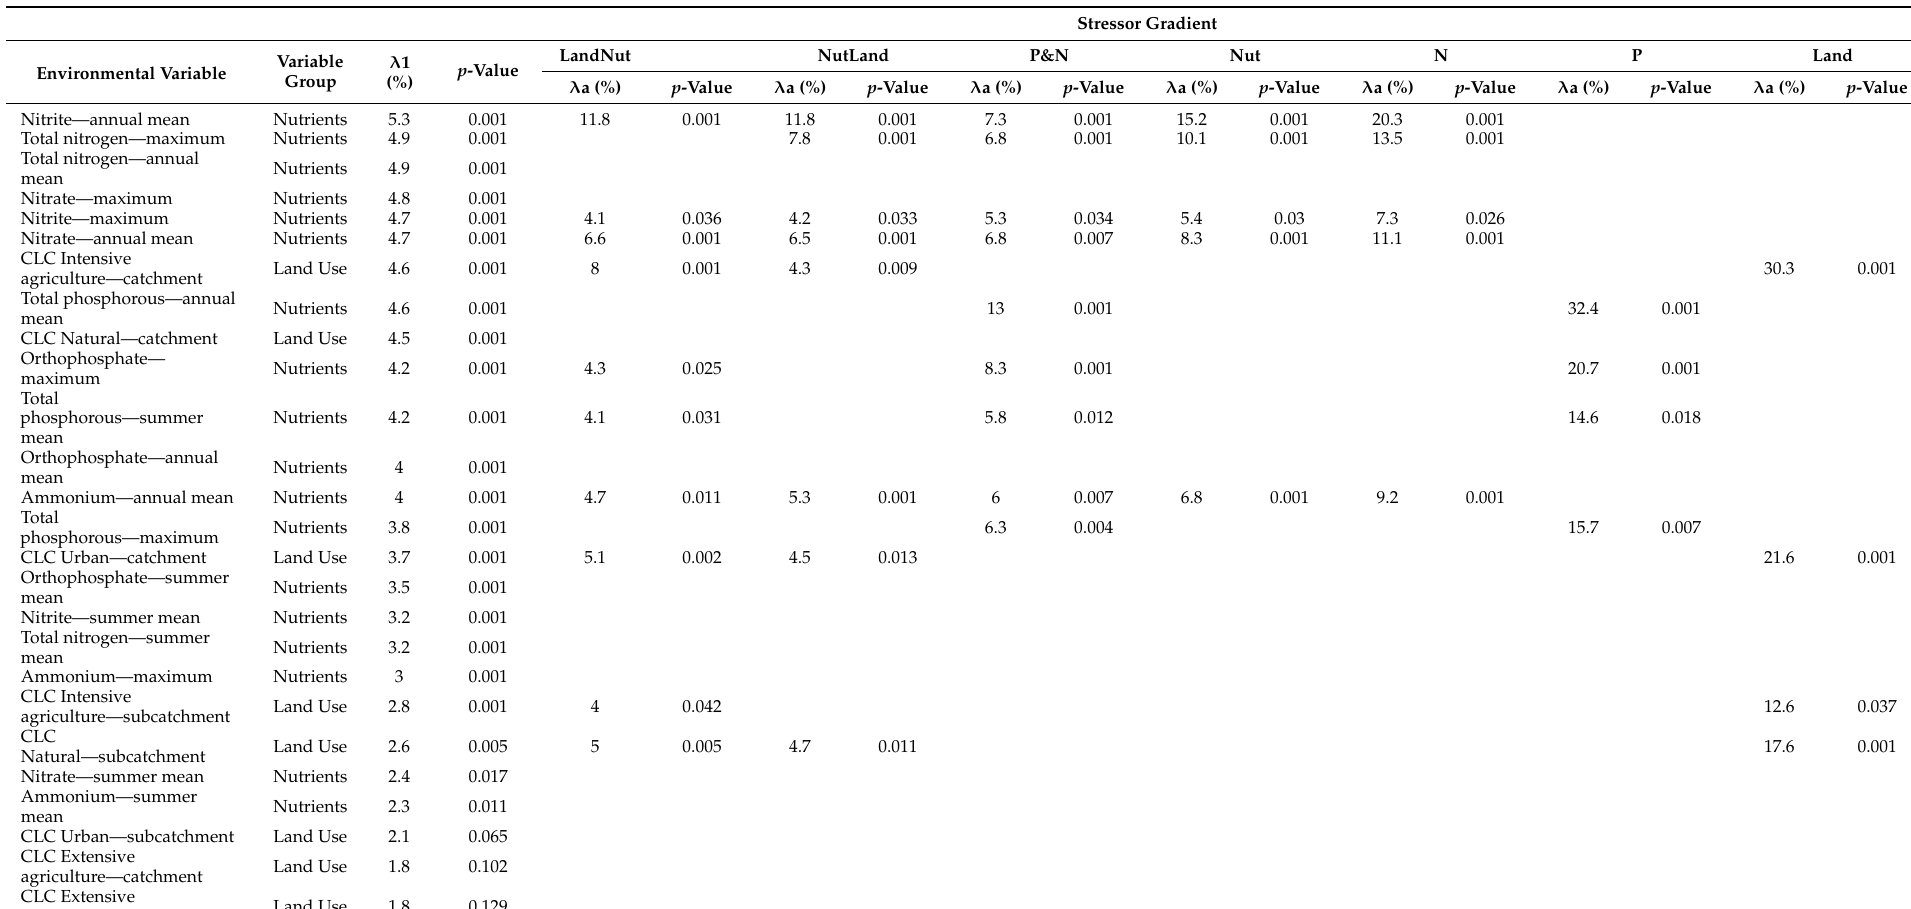
Table 5. Percentage of macrophyte assemblage variance explained by each environmental variable before forward selection ( λ 1) and after forward selection ( λ a) within each stressor gradient group. Values of λ a are given only for statistically significant explanatory variables ( p < 0.05). LandNut—land use and nutrients, NutLand—nutrients and land use, P&N—phosphorus